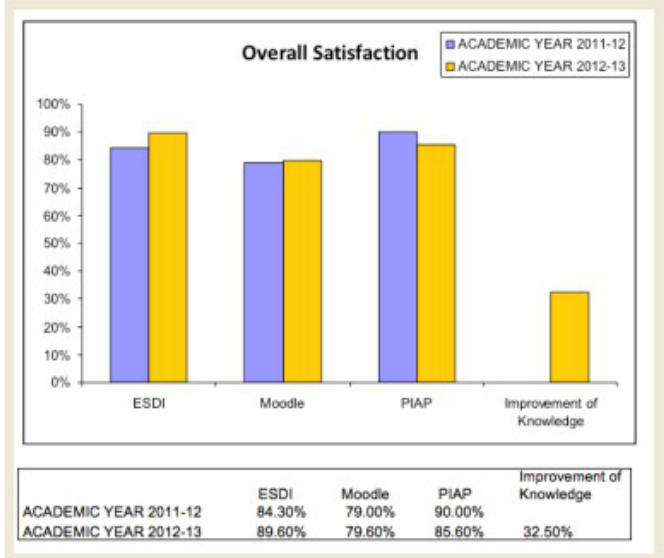
Figure 1. Overall satsfacton